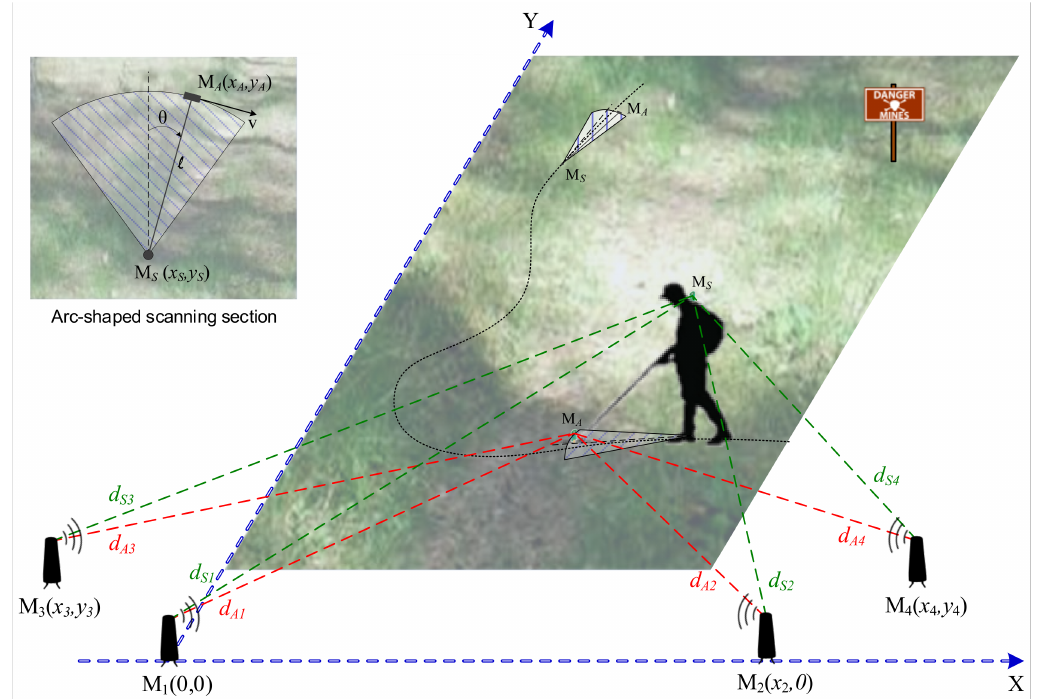
Figure 6. UWB positioning system for HH-GPR